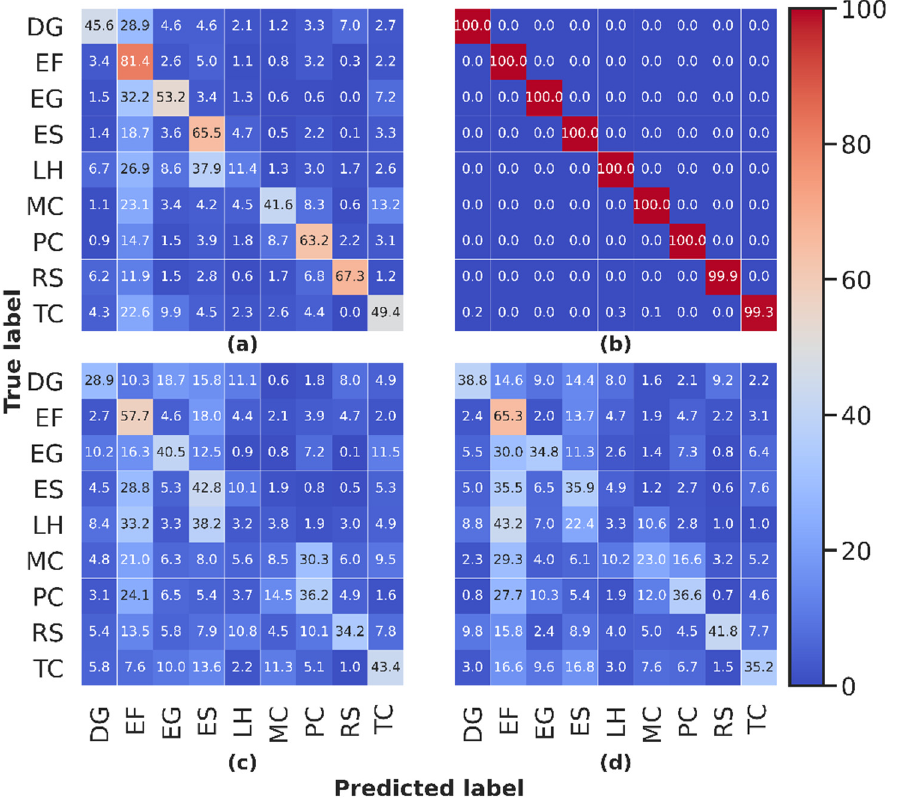
Figure 12. Confusion matrix obtained from linear discriminant analysis (LDA) performed for the classification of the nine most abundant species reported in in situ data for Site B. ( a ) imaging spectroscopy; ( b ) LOP species ; ( c ) LOP ITC ; ( d ) LOP pixel . Table 3. Pearson’s correlation coefficient comparing LDA classification of DART simulations to imaging spectroscopy for LOP level scenarios. The consistency in correct classification and mis- classification is compared between classification results obtained from airborne acquisition and classification results obtained from simulations.